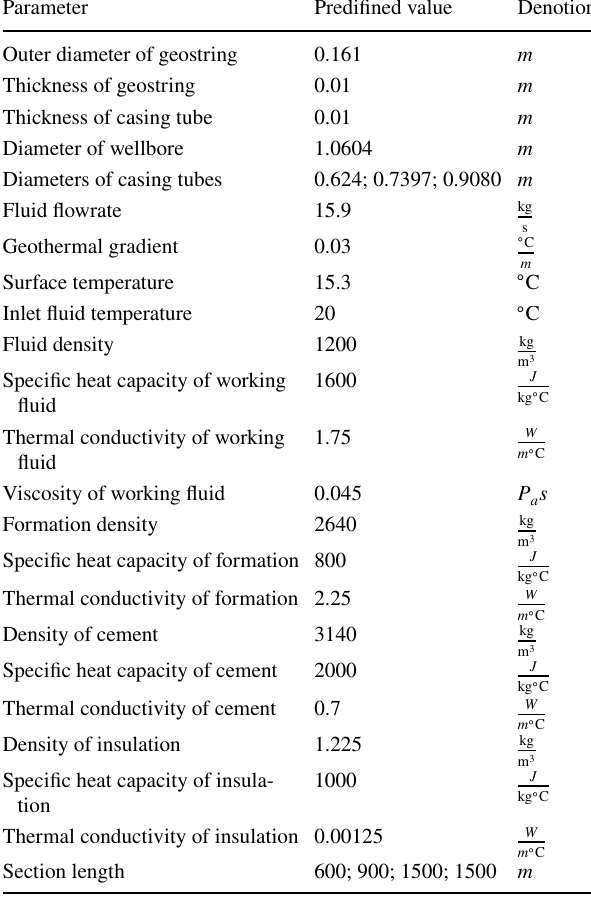
Table 2 Parameters used in the simulation